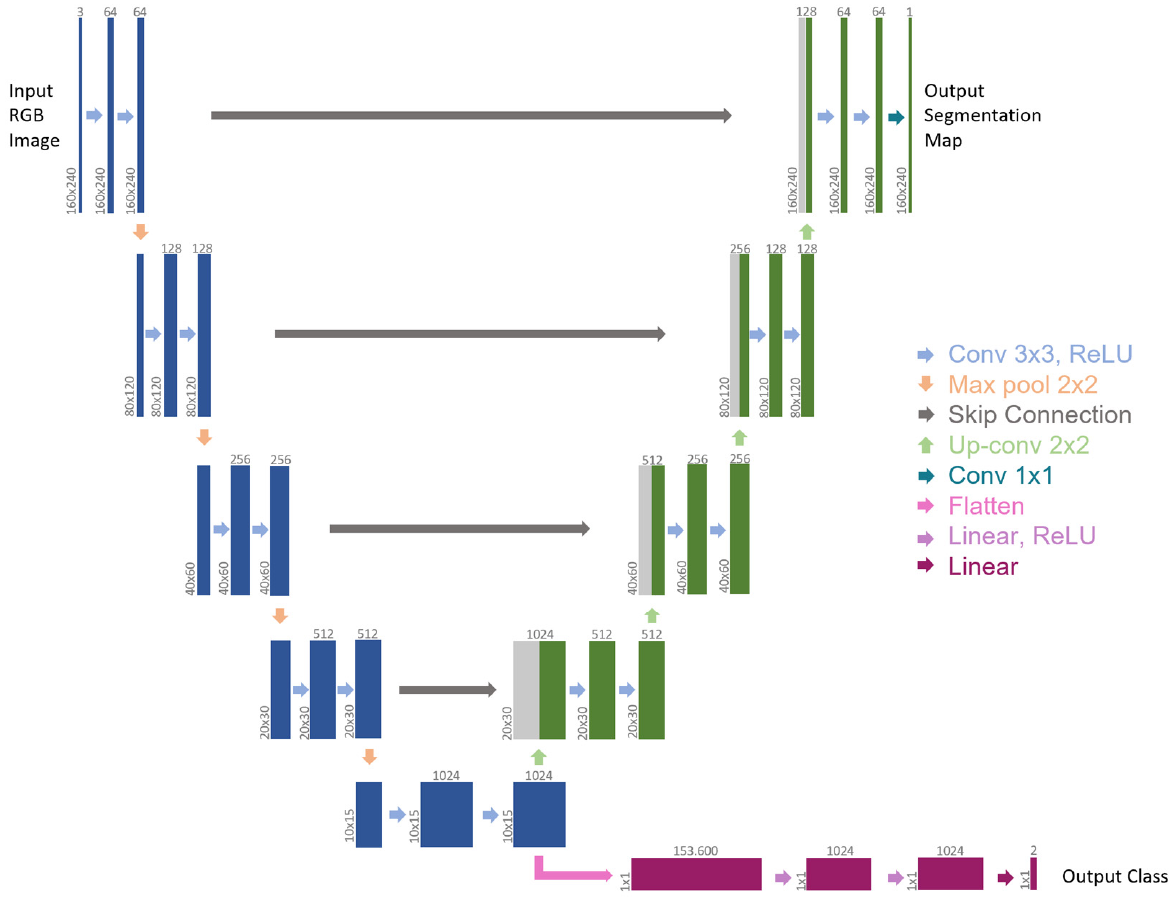
Figure 2. Multi-tasking CNN architecture (example for 160 × 240 input image). Each box represents a multi-channel feature map. The number of channels is provided on top of the box, while the x-y size is shown at the lower left edge. Blue boxes belong to the backbone, green boxes refer to the first branch for semantic segmentation, gray boxes denote copied feature maps (skip connections), and purple boxes represent the second branch for event detection. The arrows refer to the different op- erations.